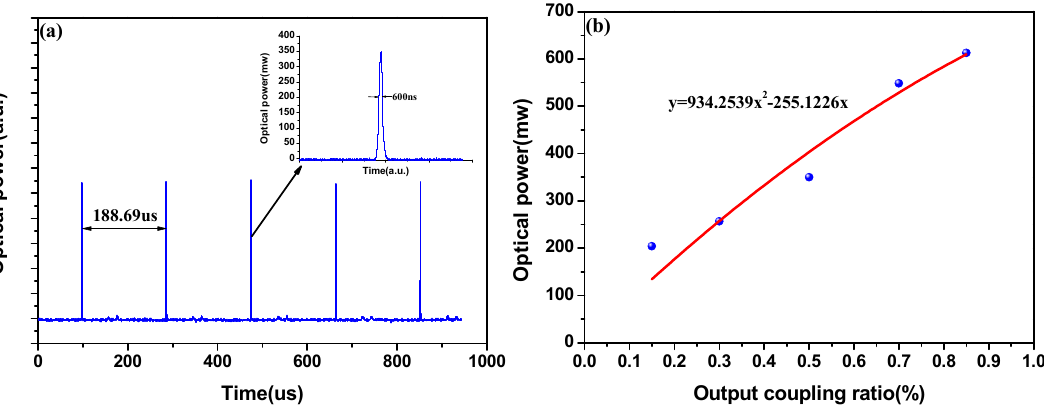
Figure 4. ( a ) Measured Q-switched pulse sequence at modulation frequency of 5.3 kHz. Inset: Typical Q-switched pulse at modulation frequency of 5.3 kHz; ( b ) Measured fiber laser output power at different output coupling ratios.